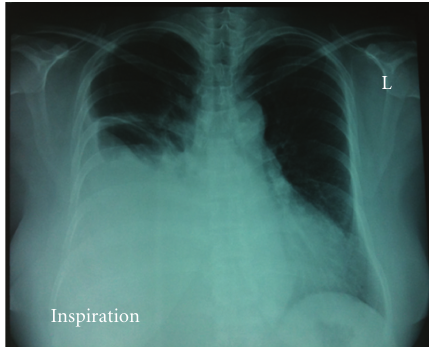
Figure 2: Follow-up chest radiograph. Table 2: Biochemical